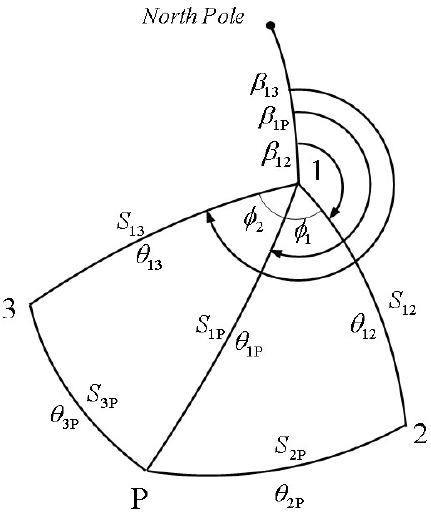
Fig. 3. The geometry of CG lightning source retrieval using only three sensors #1, #2 and #3. P is the unknown lightning location; β denotes azimuth; S and θ represent geodesic distance and radian measure distance,